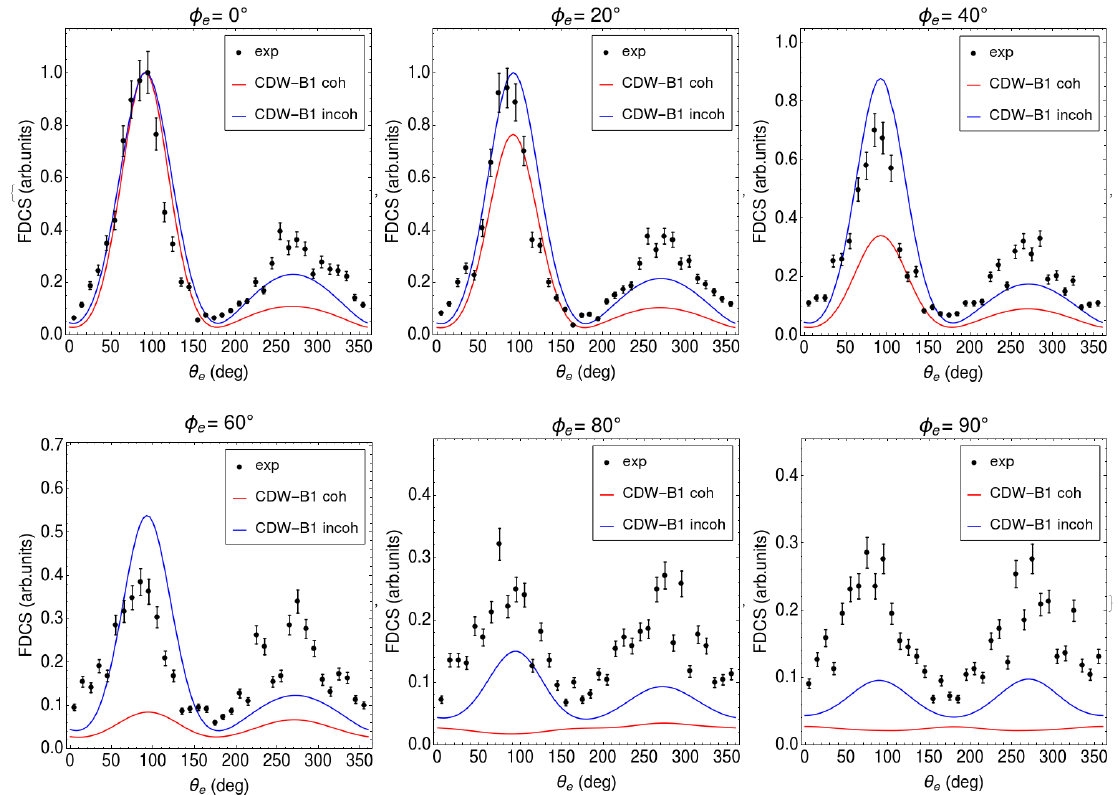
Figure 2. FDCS in arbitrary units, normalized by the maximum of the distribution, located at φ e = 0, for the single ionization of He by 100 MeV/amu C 6 + ions at different azimuthal angles φ e , for various values of the ejected electron polar angle θ e . The momentum transfer is set at Q = ( Q x , Q y , Q z ) = ( 0.75,0.00,0.02 ) au and the ejected electron energy at E e = 6.5 eV. With a red line we show the FDCS calculated in the usual coherent form with a CDW-B1 approach. The blue line corresponds to the incoherent calculation within the CDW-B1, convoluted by Equation (3), with σ x = 0.3 au and σ y = 0.6 au. Black dots represent the experimental results from